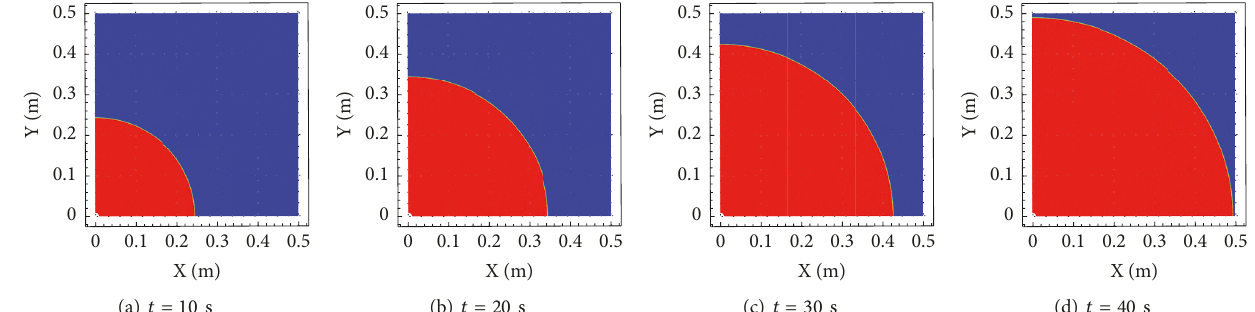
Figure 6: Simulated grout diffusion process by Fluent (2 layers model).